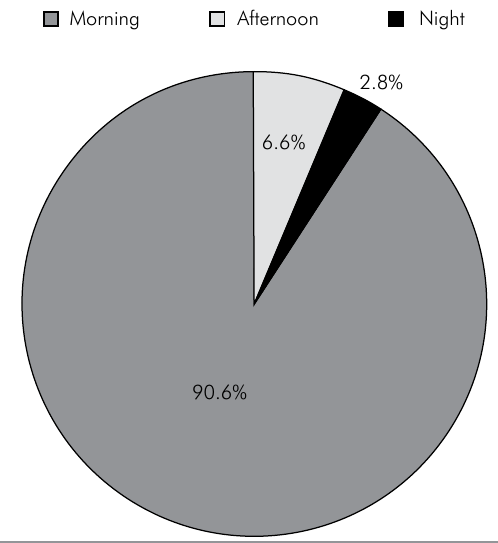
Figure 2. Periods of the day when self-reported halitosis occurred among students reporting halitosis.